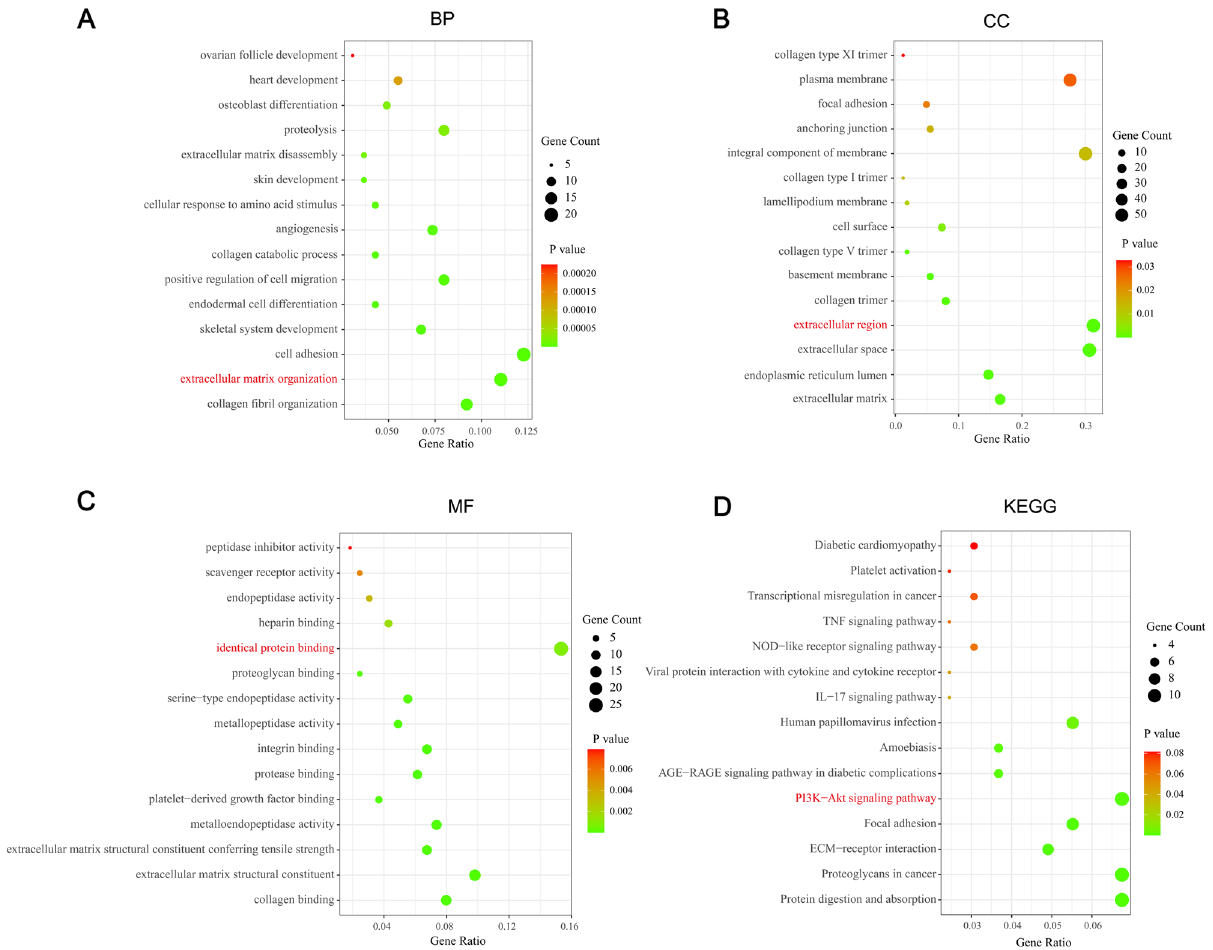
Figure 9. Functional enrichment analysis of SERPINE1 related genes in STAD. ( A ) GO:BP. ( B ) GO:CC. ( C ) GO:MF. ( D ) KEGG. The terms in red were the mainly enriched GO terms and KEGG pathway. Permission has been obtained from Kanehisa laboratories for using KEGG pathway database 11